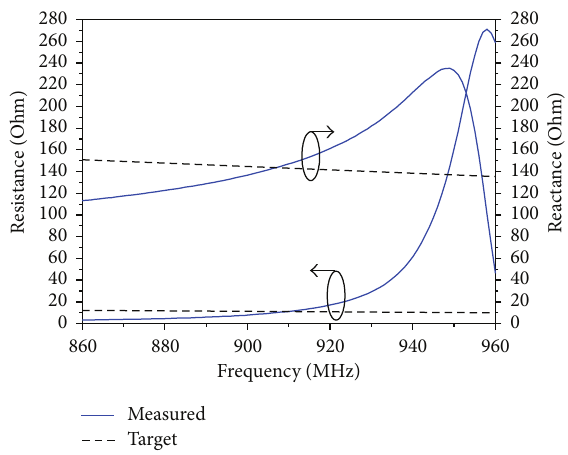
Figure 13: Measured impedance of the proposed antenna.